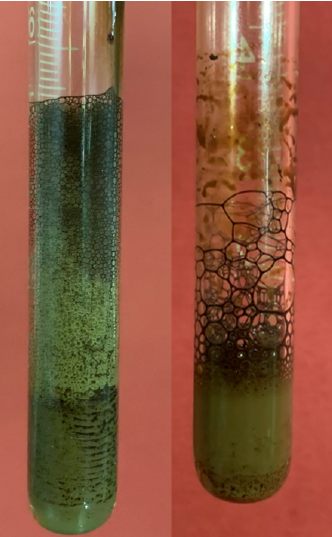
Figure 35. During core flooding experiments, we obtained high oil recovery (up to 92% cumulative OIIC, as shown in Figures 33 and 34, and we observed the foam propagation (in the produced fluid) continue pouring out of the outlet of the graduated tube from the Fraction Collector. This indicated that the foam is metastable i.e., the foam retained its stability at the replicated reservoir conditions and did not decay confirming the results of Figures 31 and 32 the fraction collector. The produced fluid from the Indiana limestone (ILS) core samples was collected in graduated